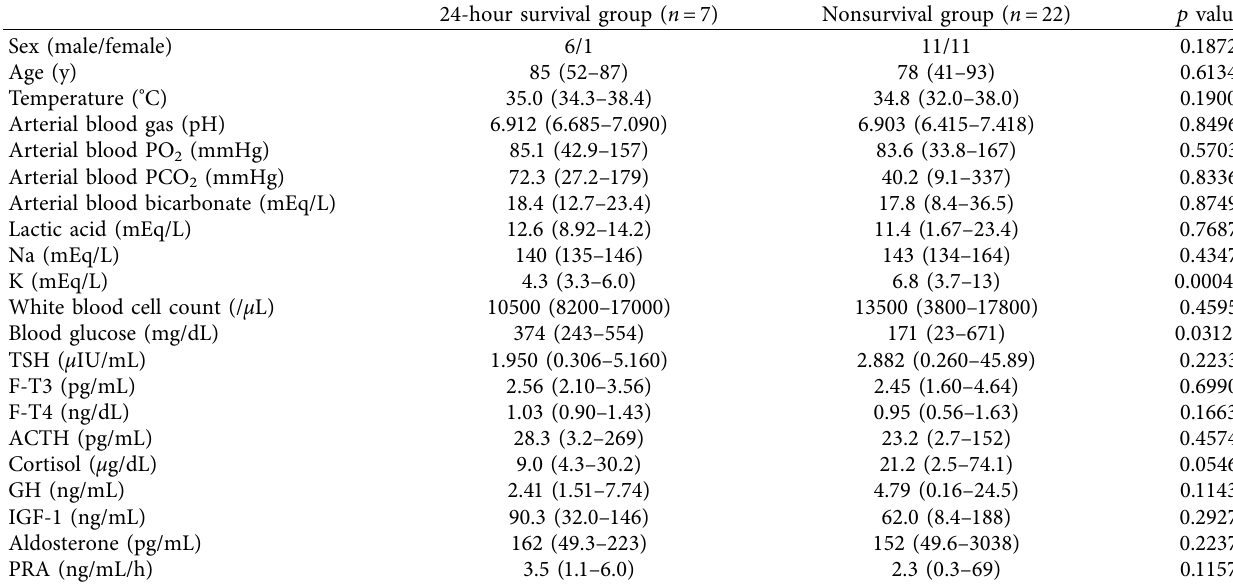
Table 5: Comparison of the 24-hour survival and nonsurvival groups in all patients ( n �